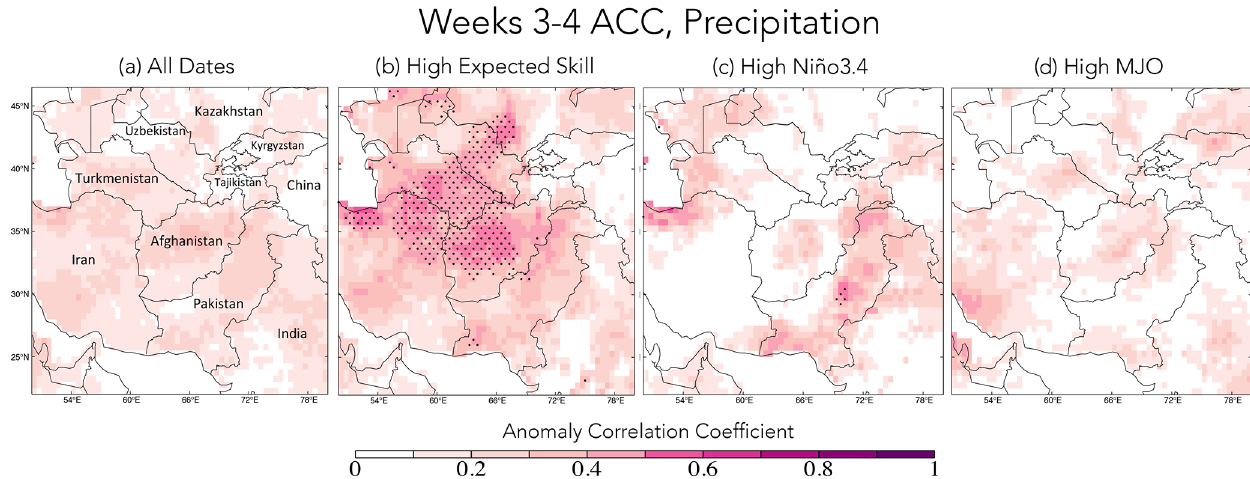
Figure 3. The anomaly correlation coefficient (ACC) for weeks 3–4 forecasts, evaluated from January–March 1982–2020. (a) The ACC for all dates in the record; (b) the ACC for the 20% of forecasts initialized with the highest expected skill; (c) the ACC for the 20% with the highest Niño3.4 amplitude; (d) the ACC for the 20% with the highest RMM amplitude. The black stippling indicates where the skill of the top 20% of forecasts in each group is statistically significantly different from the skill of the remaining 80% of forecasts at the 95% confidence level, determined nonparametrically with bootstrapping.